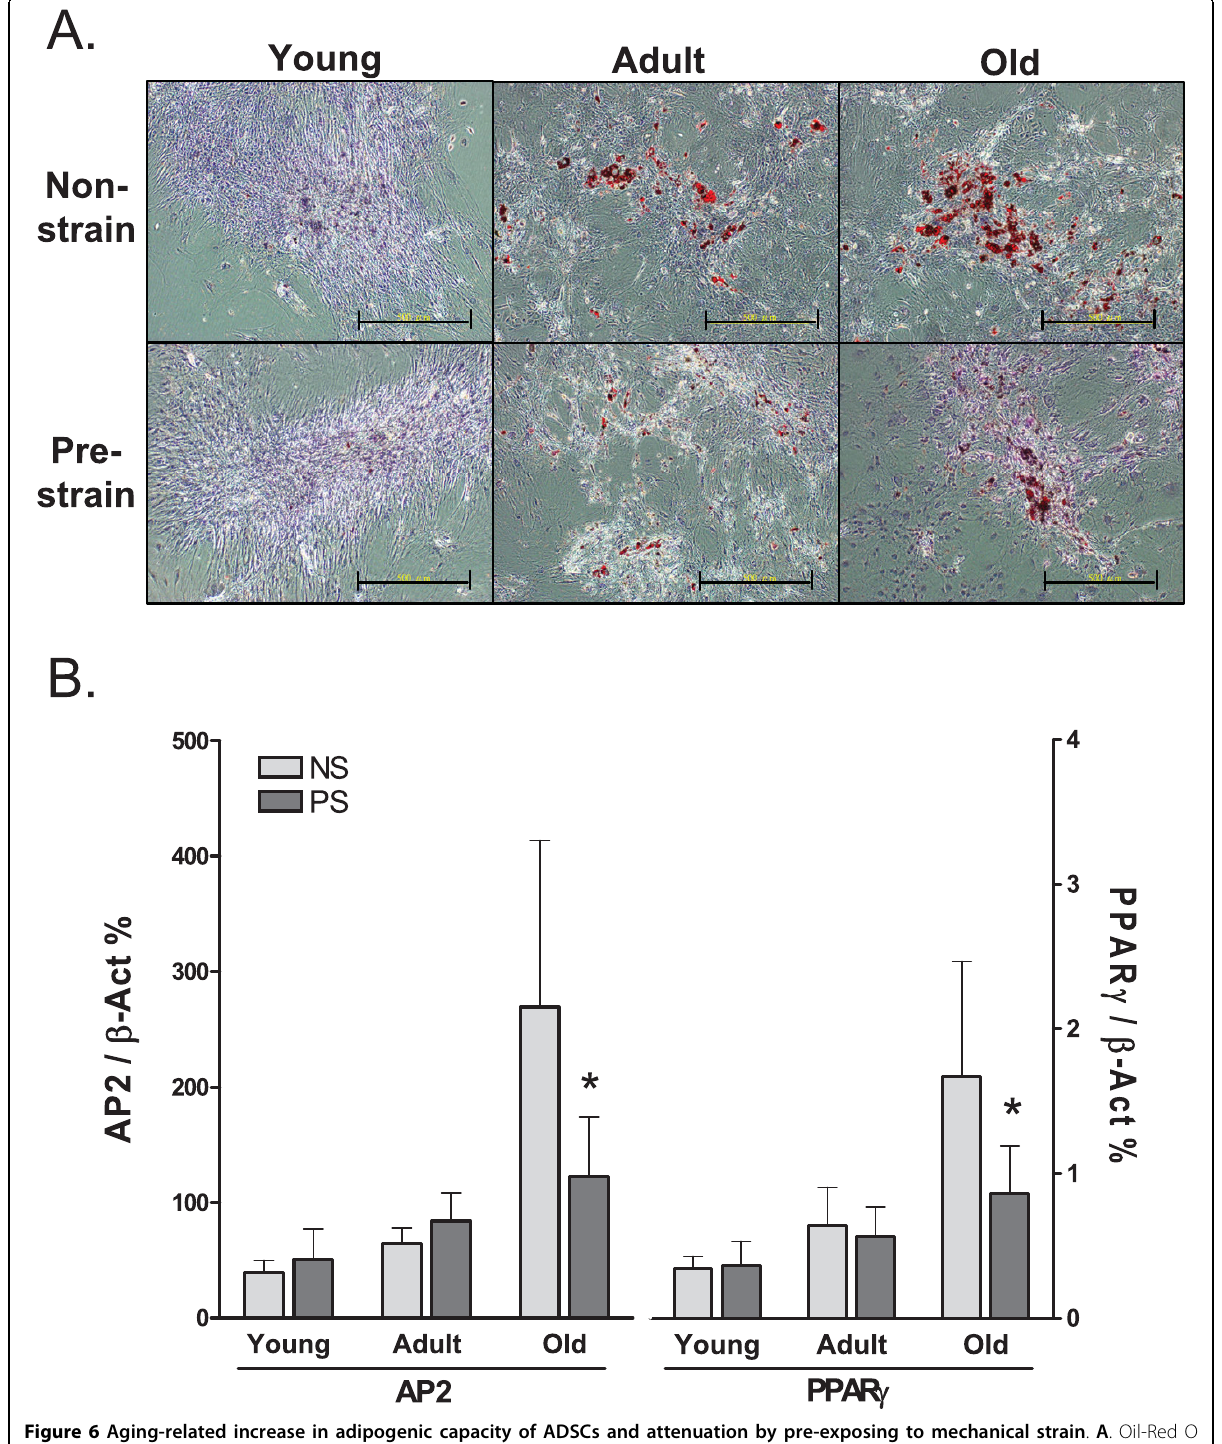
Figure 6 Aging-related increase in adipogenic capacity of ADSCs and attenuation by pre-exposing to mechanical strain . A . Oil-Red O staining of adipogenic colonies (14 days) formed by young, adult, and old ADSCs with or without pre-strain. Scale bars = 500 μ m. B . AP2 and PPAR g expression in ADSCs that were with or without pre-strain and were adipogenically induced for 14 days *: P < 0.05, compared to non- strained old ADSCs. N =